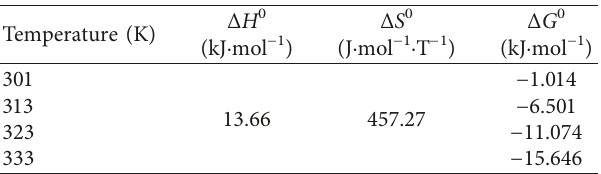
Table 7: Thermodynamic parameters of RDB adsorption on MIL- 101. Temperature